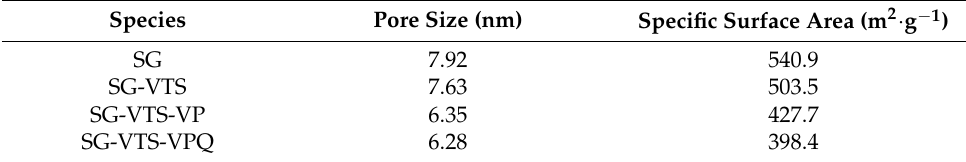
Figure 10. Pore size distribution of SG, SG-VTS, SG-VTS-VP and SG-VTS-VPQ. Table 2. Changes of specific surface area and pore size with the progress of grafting.